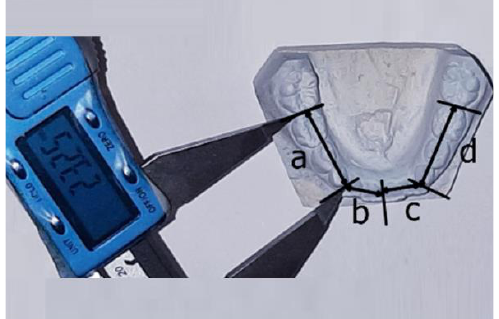
Figure 2. Measurement of the available space on mandibular cast: a = length between the mesial contact point of the lower right first permanent molar and the mesial contact point of the lower right canine, b = length between mesial contact point of the lower right canine and the midline; c = length between the midline and the mesial contact point of the lower left canine; d = length between the mesial contact point of the lower left canine and the mesial contact point of the lower left first permanent molar.